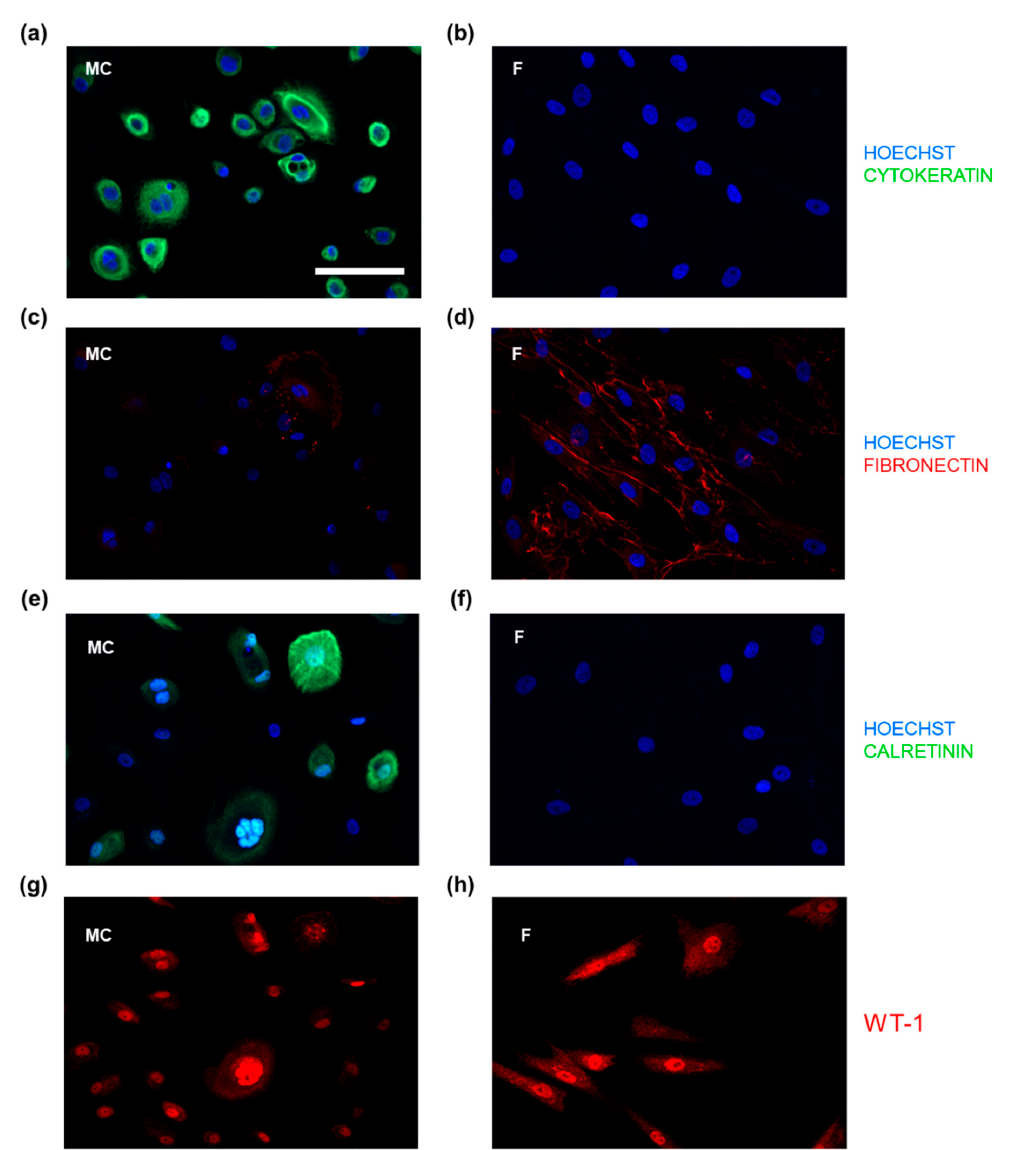
Figure 2. Characterization of PWC-derived mesothelial cells and distinction from peritoneal fibroblasts. Mesothelial cells (MC) were isolated from PWC, fibroblasts (F) were isolated from peritoneal tissue samples. Both cell types were cultured for 3 to 4 days. Immunofluorescence staining of MC and F for cytokeratin ( a , b ), fibronectin ( c , d ), calretinin ( e , f ) and WT-1 (Wilms’ tumor protein) ( g , h ) was performed. ( a ) MC showed a high expression of epithelial marker cytokeratin, while ( b ) F were found to be negative. ( c ) Some of MC showed a low expression of fibronectin, whereas ( d ) F exhibited a high expression of fibronectin. ( e ) MC expressed calretinin in varying intensities in contrast to ( f ) F, which were negative for calretinin. ( g ) MC and F ( h ) showed a high and similar expression of Wilms’ tumor protein 1 (WT-1). Scale bar represents 100 µm.